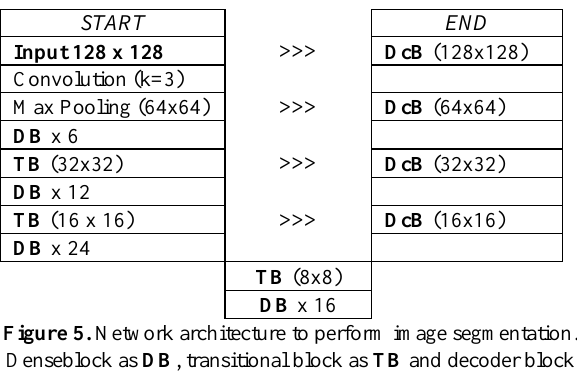
Figure 4 Dense, transitional and decoder blocks used to build the network in Figure 5. The indicated convolutions are always followed by batch normalization and relu. >>> indicates input to the concatenation in the decoder block. k , kernel size.